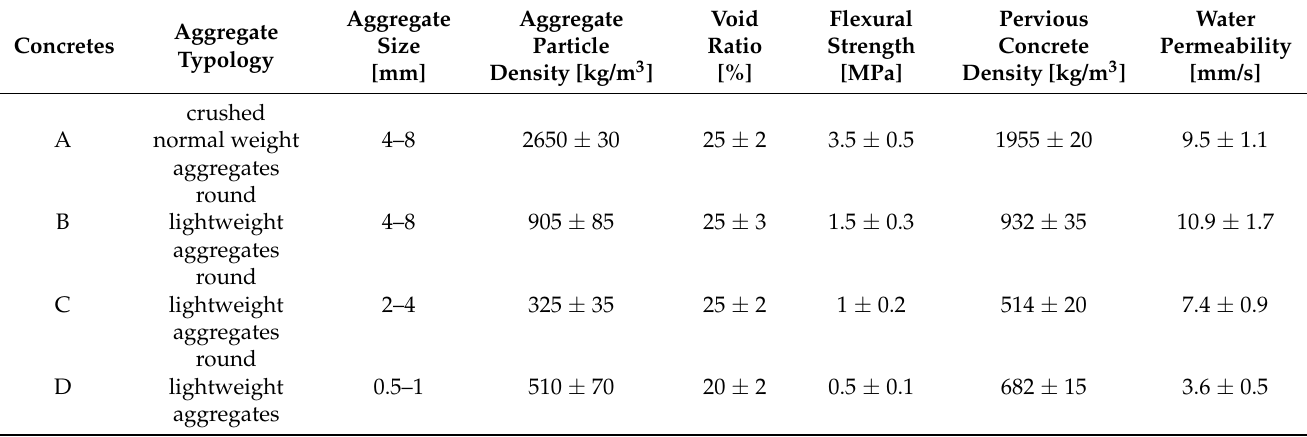
Table 1. Four mix design of porous concrete characteristics with respect to: aggregate size, aggregate particle density, void ratio, flexural strength, previous concrete density, and water permeability.